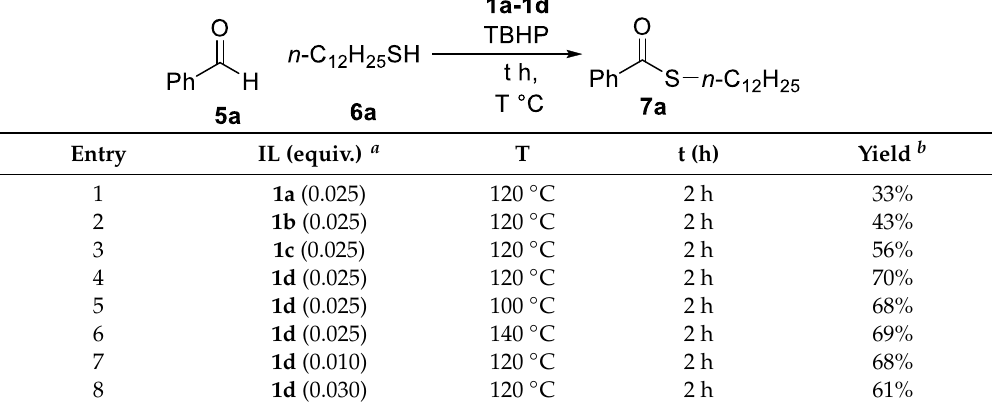
Figure 3. Proposed mechanism of Friedel–Crafts acylation.